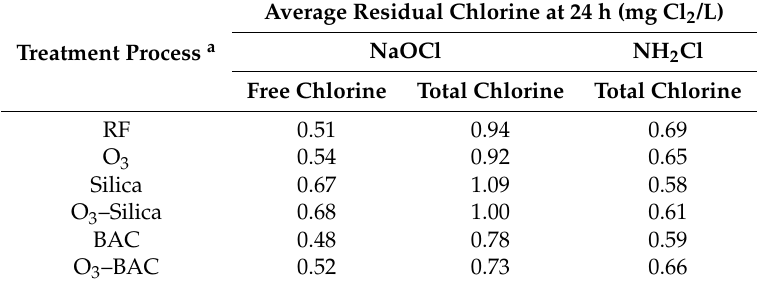
Table 1. Residual disinfectant concentrations at the end of the simulated distribution system tests (24 h SDS tests) for the proposed treatment